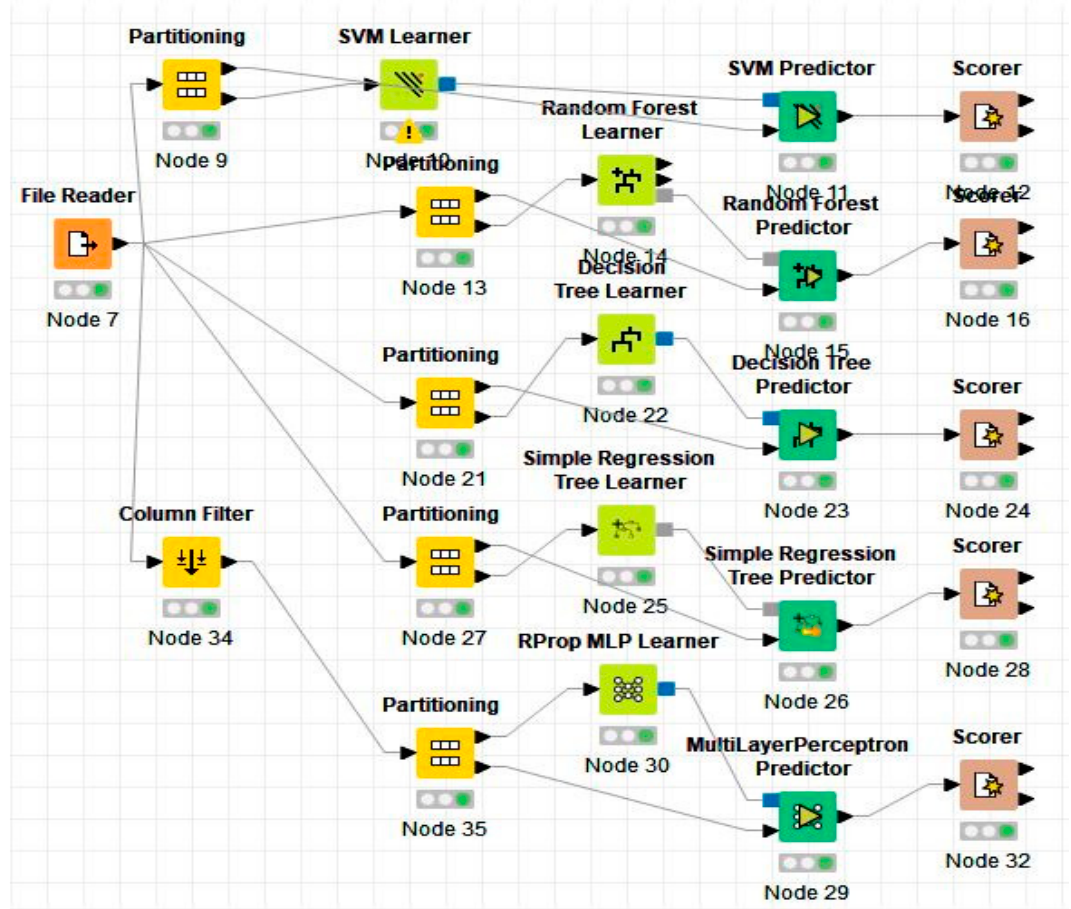
Figure 8. KNIME Analysis. Table 5. Testing